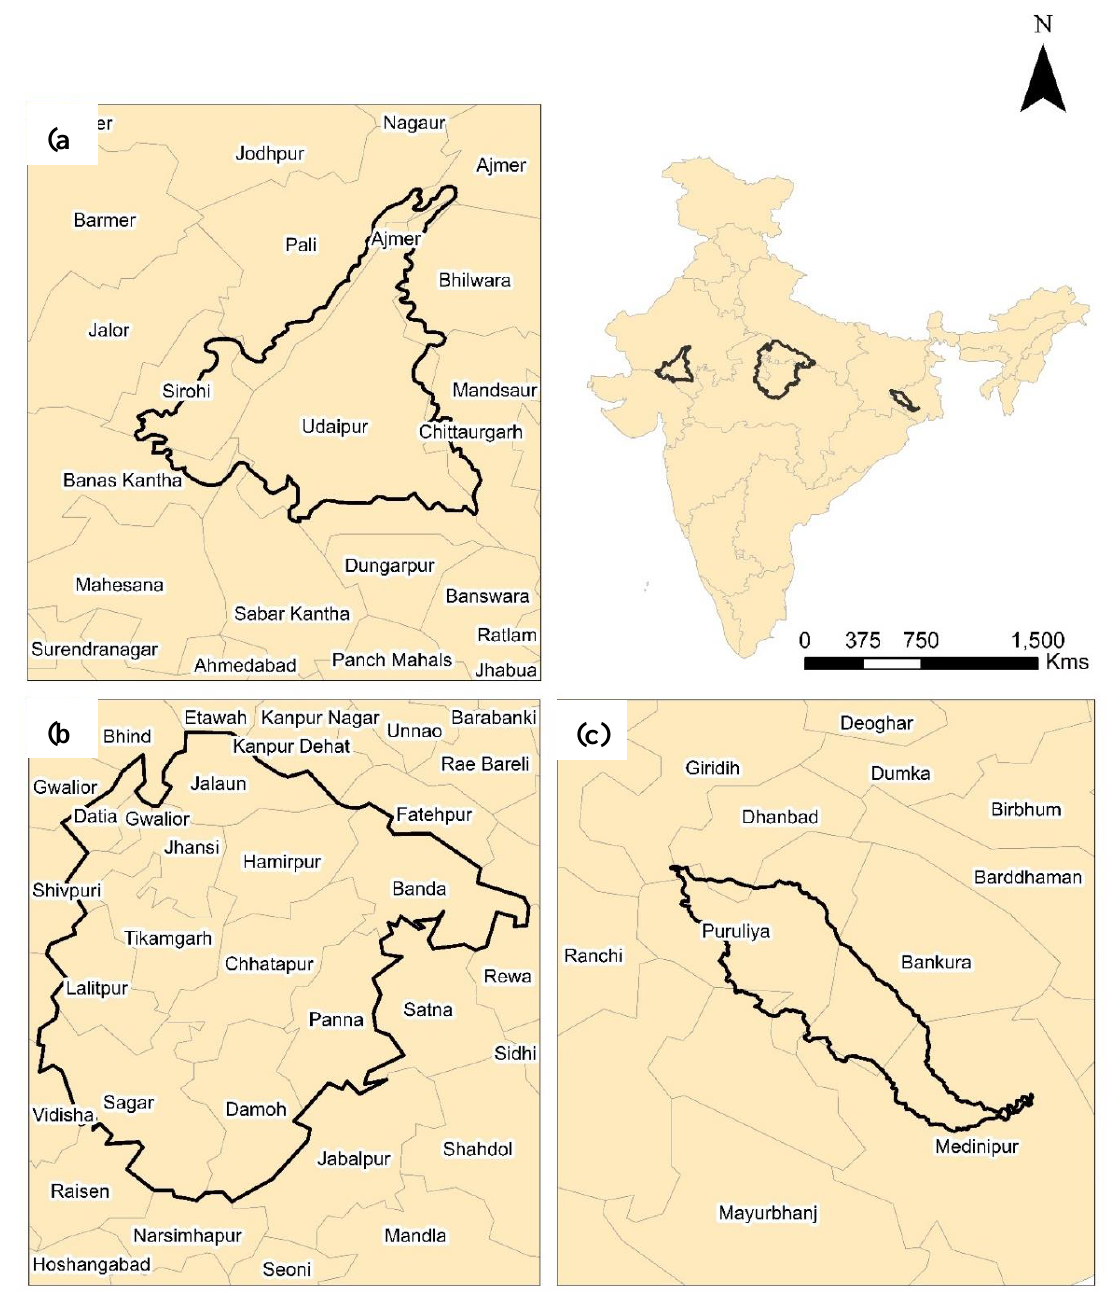
Figure 1. Study area map of each of the study area. ( a ) Araveli region ( b ) Bundelkhand region ( c ) Kansabati river basin.